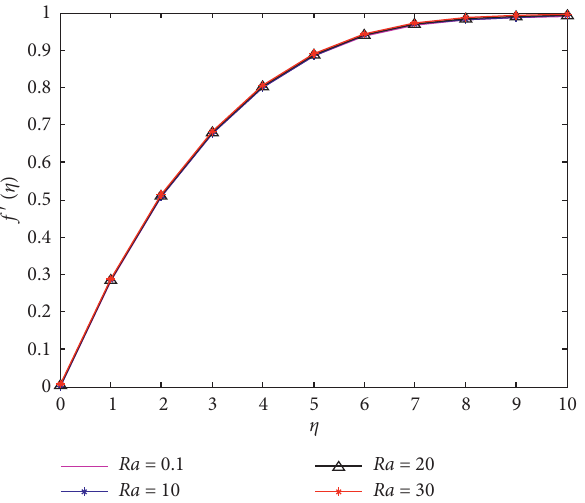
Figure 3: Velocity profiles for various values of the radiation parameter when Pr � 0.72, Gr � 0.1, M � 0.1, λ � 0 . 1, and Bi � 0.1.